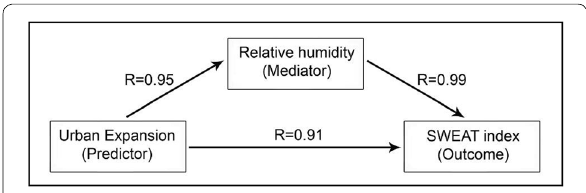
Fig. 8 Mediated relationship model among the study variables (urban expansion predictor, relative humidity = SWEAT index =